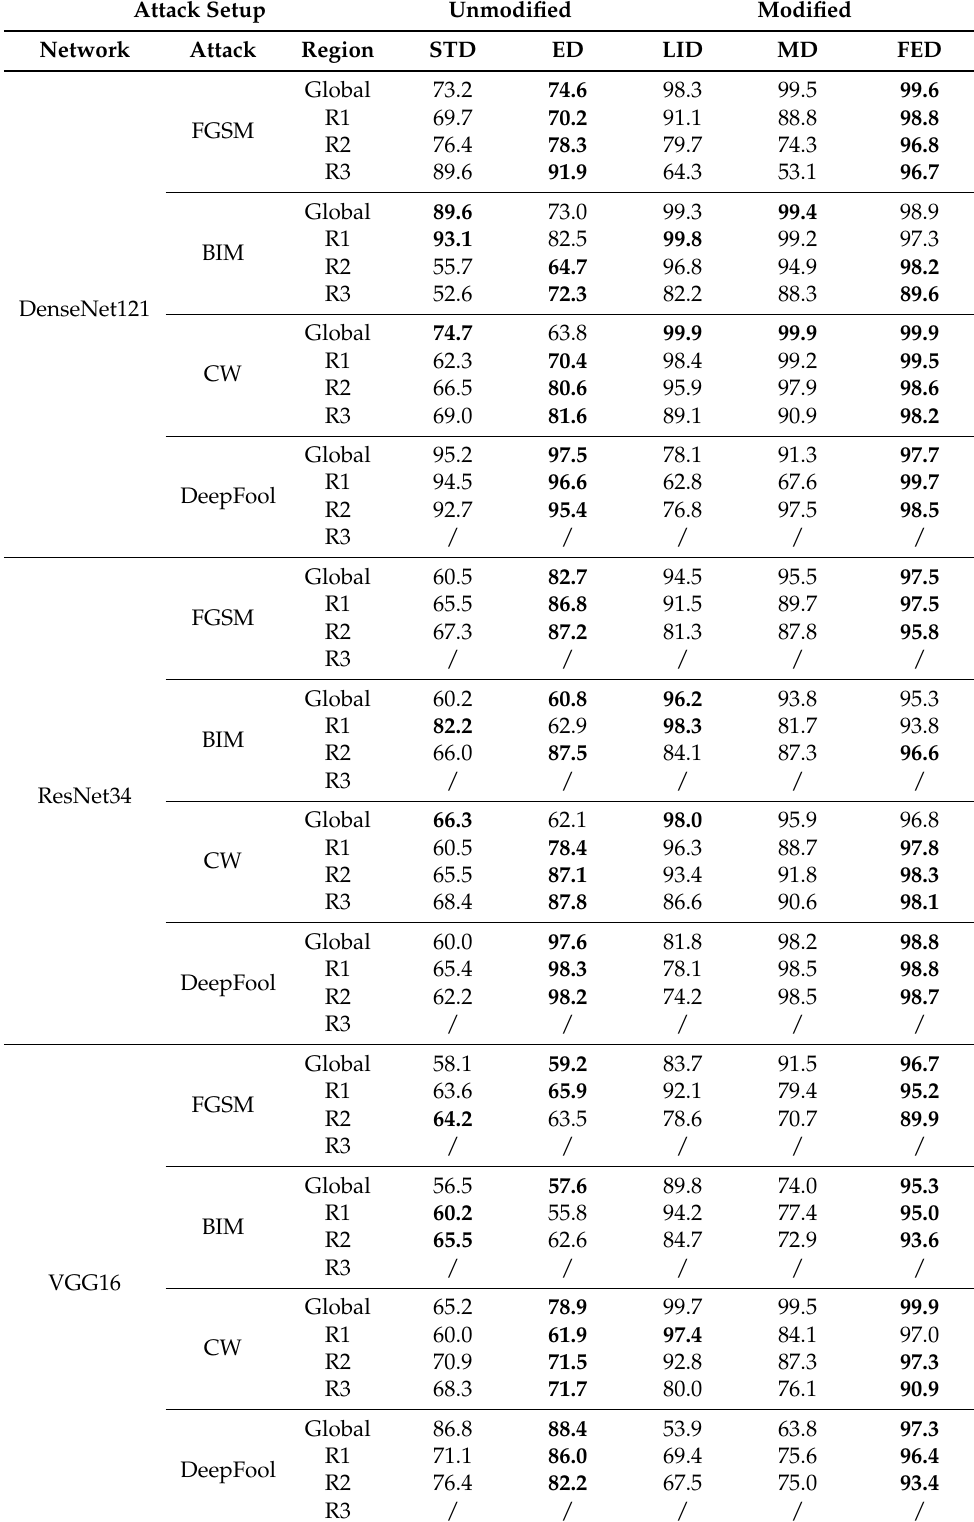
Table 3. Comparison of the AUROC against SAR AEs between the proposed methods and classic methods